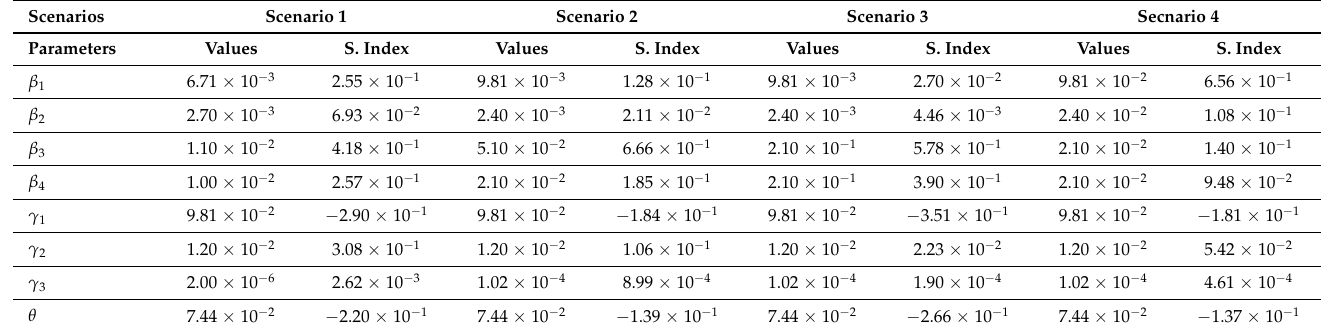
Table 1. Sensitivity index for each parameter that has a direct correlation to R 0 Total